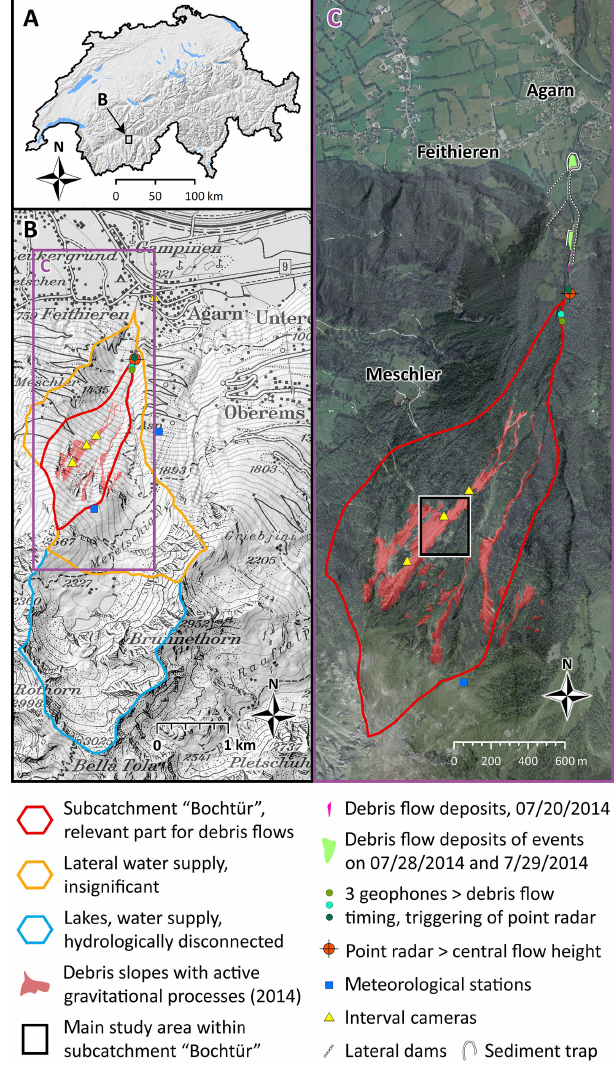
Figure 1. (a) Location of the Meretschibach catchment in south- ern Switzerland. (b) Subcatchments of the Meretschibach and loca- tions of the instrumentation site and data available for the erosion model analyses (c) . Initiation zone of the July 2014 events and cam- era positions. The main study channel reach for the model testing is located in the middle part of “Bochtür” (black-white retangle), swissimage© 2014, swisstopo (5704000000) (2014). Date format: